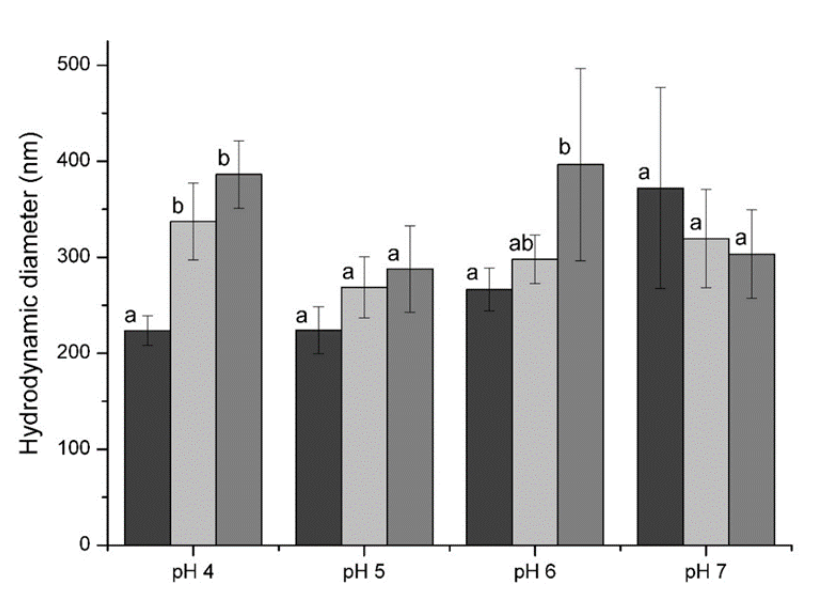
Figure 2. Size of nisin-loaded ulvan particles at different pH values depending on nisin concentration: 0.0 mg/mL— ; 0.1 mg/mL— ; 0.2 mg/mL— . Final concentration of ulvan in the solution was equal to 0.4 mg/mL. Different letters indicate significant differences ( p < 0.05) in the mean of the size of particles within the group of each pH value.